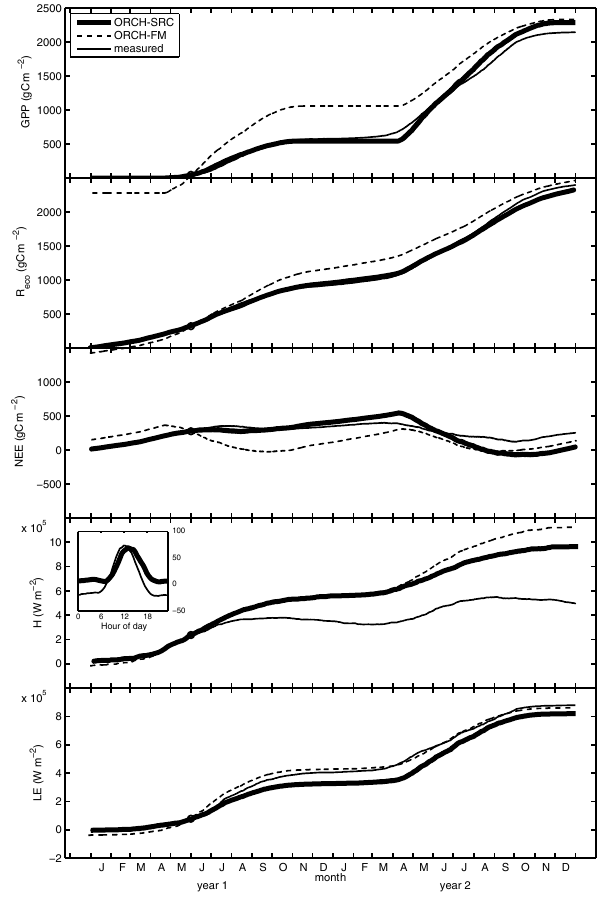
Figure 4. Cumulative fluxes of gross primary production (GPP), ecosystem respiration ( R eco ) , net ecosystem exchange (NEE), sen- sible heat ( H ) and latent heat (LE) for the POPFULL site. The inset in the graph for sensible heat flux shows the average diurnal cycle of the sensible heat flux. The thin solid lines are the measured val- ues from the eddy-covariance measurements or recalculated from these measurements using the flux-partitioning tool of the Max Planck Institute for Biogeochemistry (http://www.bgc-jena.mpg.de/ ~MDIwork/eddyproc/). The dashed lines are the model outputs us- ing the standard model ORCHIDEE-FM. The solid thick lines are the model outputs using the modified model ORCHIDEE-SRC. Since there were no flux measurements before June 2010, both sim- ulated and measured values coincide before that